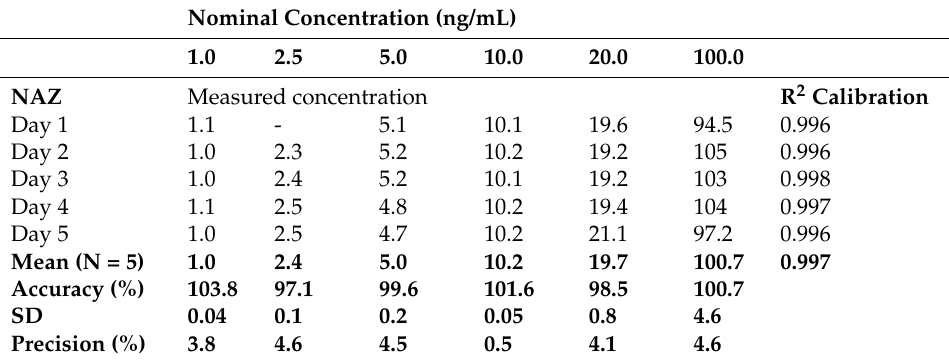
Table 1. Linearity, accuracy, and precision of the NAZ calibration curve in plasma.